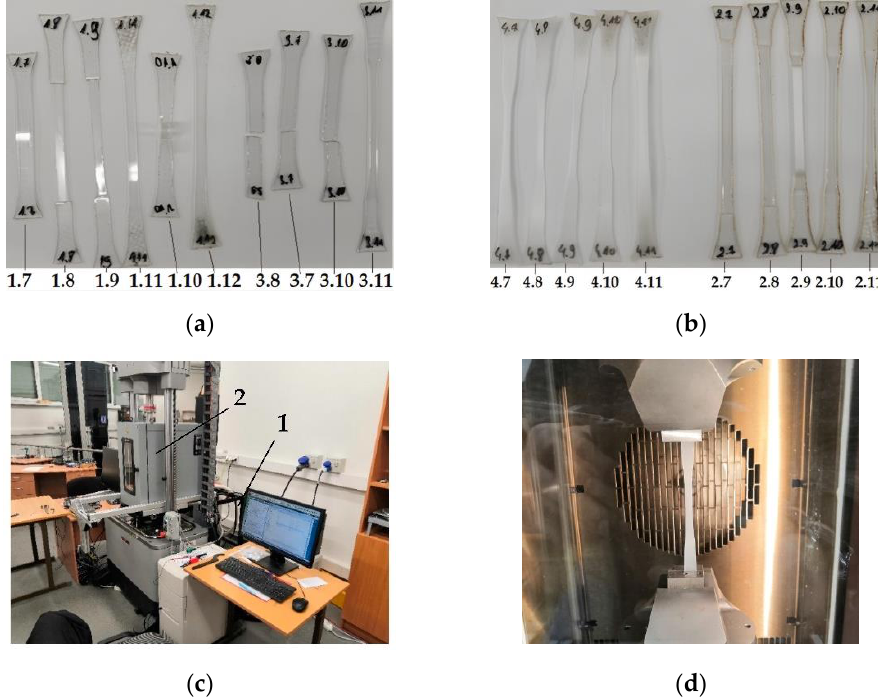
Figure 1. Tensile experiment. Specimens after the experiment: ( a ) 1.7 – 1.12 — PVC, 3.7 – 3.11 — SAN; ( b ) 4.7 – 4.11 — PP, 2.7 – 2.11 — PETG; ( c ) Testing machine Instron E10000: 1 — control computer, 2 — ( b ) 4.7–4.11—PP, 2.7–2.11—PETG; ( c ) Testing machine Instron E10000: 1—control